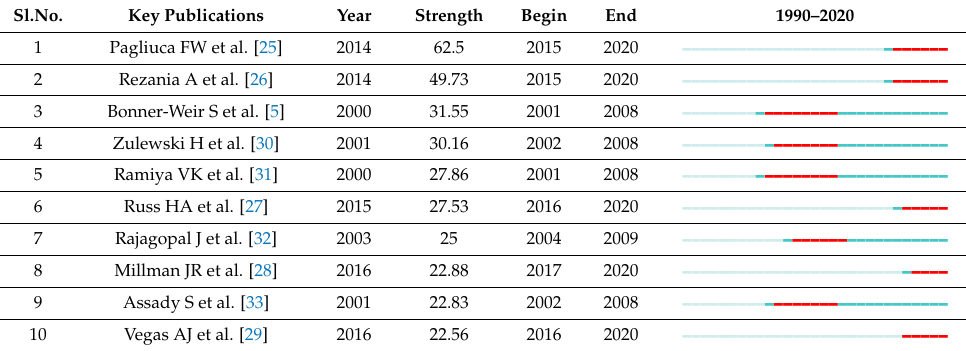
Table 1. Top 10 articles on stem cell therapy for diabetes based on the strength of their citation frequency